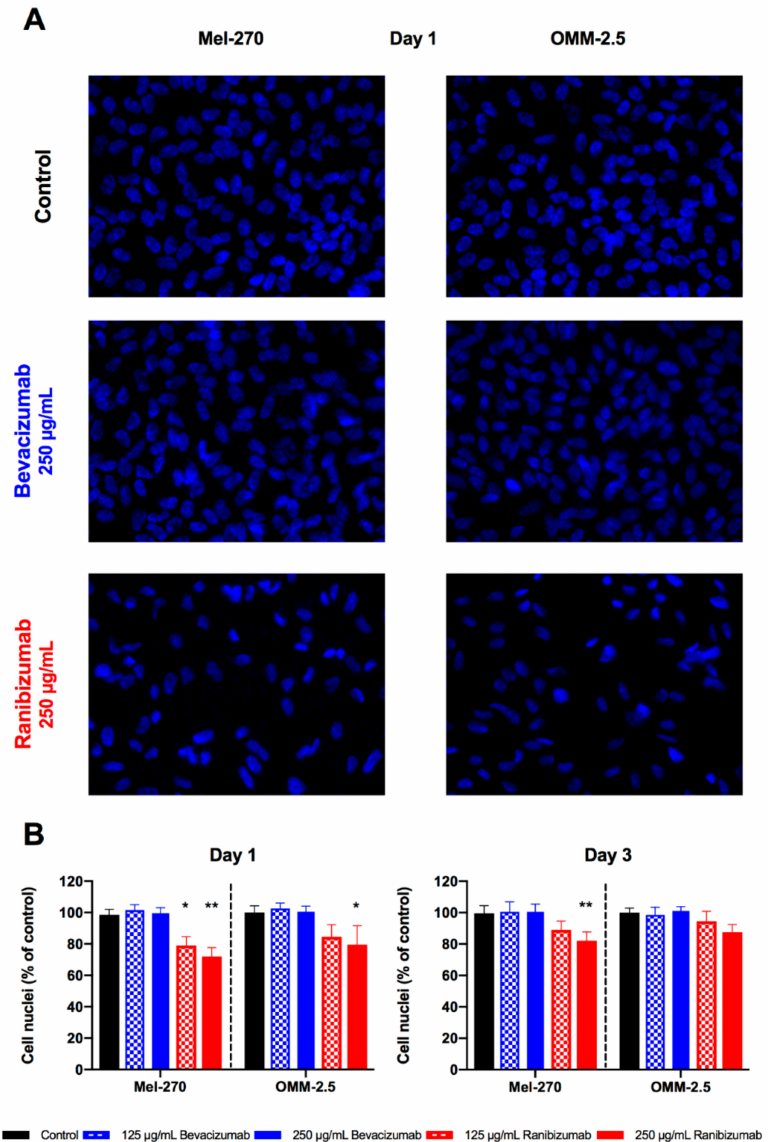
Figure 5. E ff ect of a 1-day exposure to bevacizumab and ranibizumab on uveal melanoma (UM) cell proliferation. ( A ) Fluorescent images were binarized and the number of cell nuclei were automatically counted. Images are shown for both UM cell lines after incubation with 250 µ g / mL bevacizumab or ranibizumab at day one, compared to the untreated (control) cells. Images were acquired at 200 × magnification. ( B ) Bevacizumab did not have any significant e ff ect on cell proliferation,